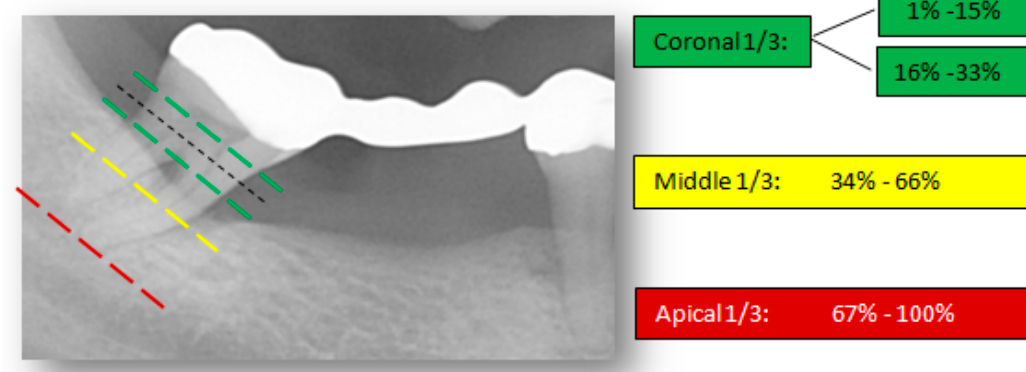
Figure 2. Visual interpretation of bone loss severity. The ‘worst’ tooth in each quintet is visually divided into coronal, middle, and apical thirds and the percentage of alveolar bone loss is measured accordingly.